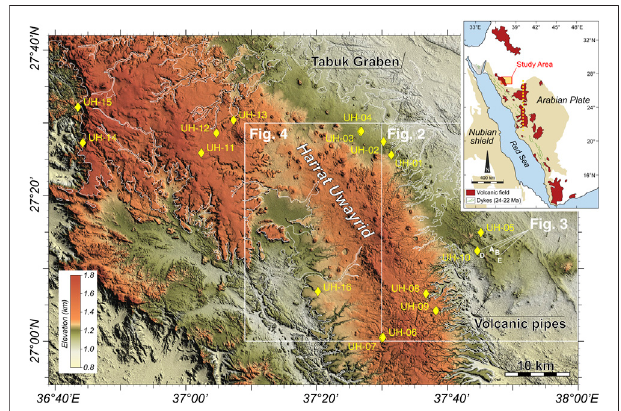
FIGURE 1 | Topography of the Uwayrid lava fi eld region and its main morphological features. Yellow diamonds indicate locations of sampling sites. The insert in the upper right corner shows distribution and ages of Cenozoic Arabian volcanism (dark red areas), modi fi ed from Stern and Johnson (2010) and Bosworth and Stockli(2016).The thickdottedyellowlineindicates the Makkah-Madinah-Nafud (MMN) lineament corresponding to the most voluminous volcanic province of western Arabia. Beige fi lled area shows the extent of the Nubian and Arabian Shield. Mercator projection at 27 ° N, datum